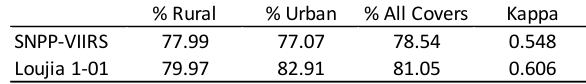
Table 7. Adjustment accuracy indicators